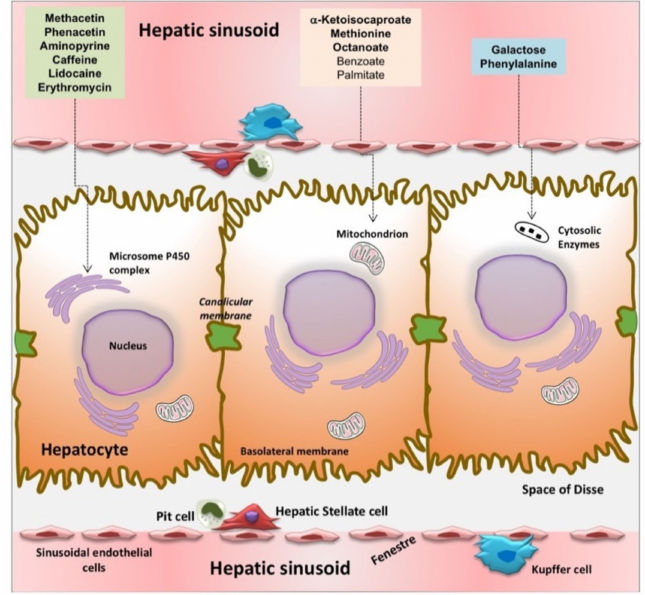
Figure 3. Structure of the hepatic sinusoid and types of substrates used for breath test analysis of liver function. The hepatic sinusoid represents a unique, dynamic microvascular structure. It serves as the principal site of exchange between the blood, and the space of Disse (perisinusoidal space). The main nonparenchymal cells populating the sinusoid are the fenestrated sinusoidal endothelial cells in contact with the blood, the phagocytic Kupffer cells, which adhere on the luminal aspect, and the hepatic stellate cells which are specialized pericytes that extend processes throughout the space of Disse. They serve as myofibroblasts during times of hepatic injury and repair, liver-associated lymphocytes (Pit cells). This mass of sinusoidal nonparenchymal cells account for approximately 6% of the total liver volume, and about 30% of the total number of liver cells. At the liver sinusoid, several substrates are used to explore liver function by a breath test (see text for details)